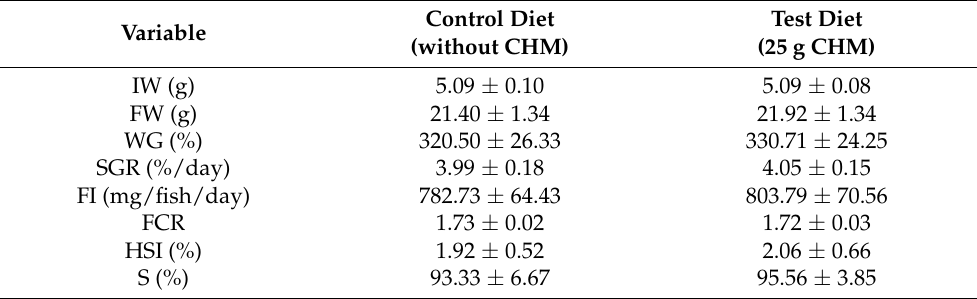
Table 2. Growth parameters and feed efficiency of Nile tilapia fed experimental diets for 36 days.